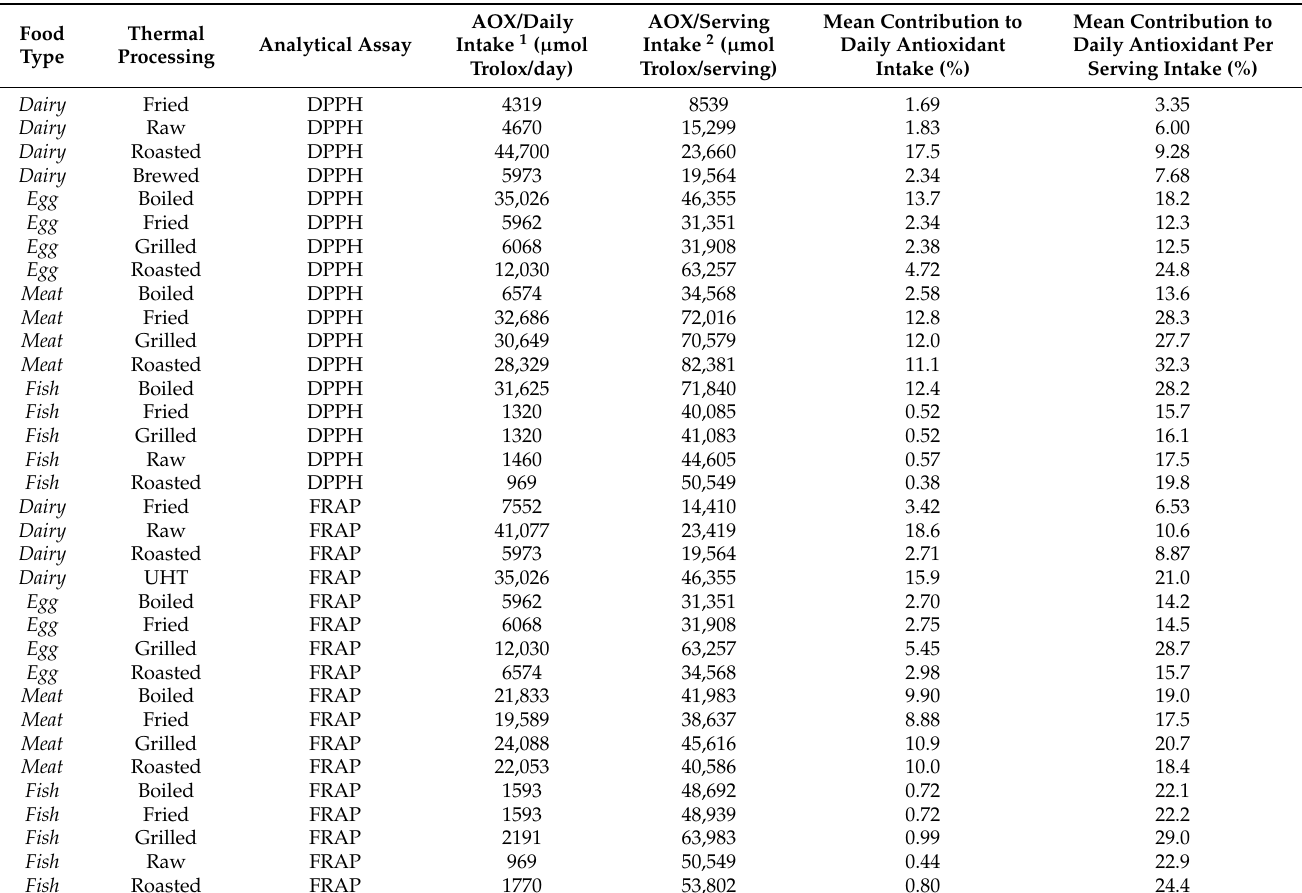
Table 2. Contribution of food of animal origin, with different culinary treatments, consumption to the daily antioxidant capacity (AOX) intake in the Spanish